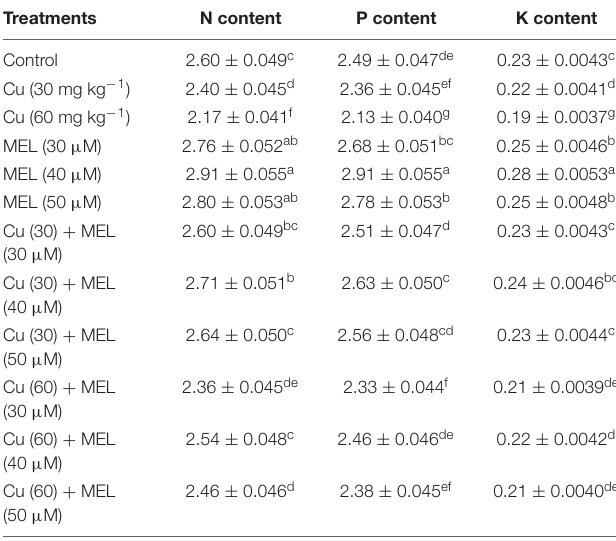
TABLE 7 | Effect of different levels of soil applied Cu (0, 30 or 60 mg kg − 1 ) and/or MEL (30, 40 or 50 µ M) on nitrogen content (% DW), potassium content (% DW), and phosphorus content (% DW) of Brassica juncea at 45